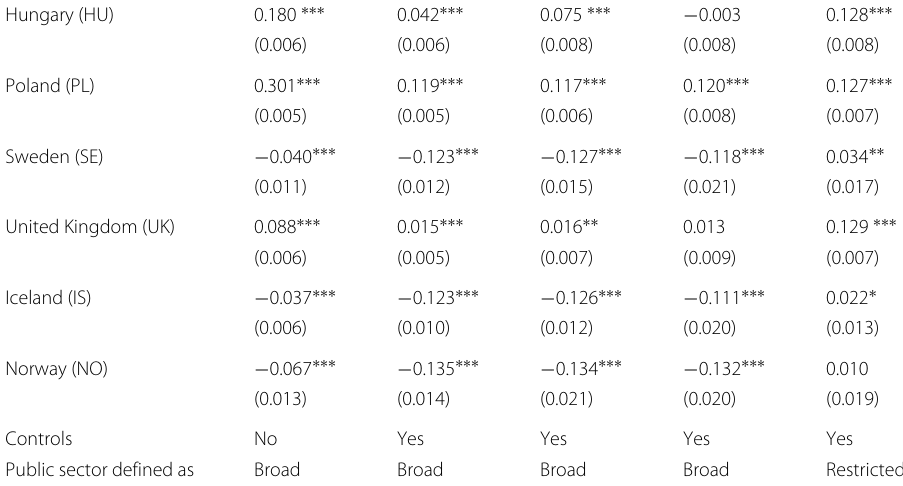
Table 1 Estimates of the public pay gap EU-SILC 25 countries